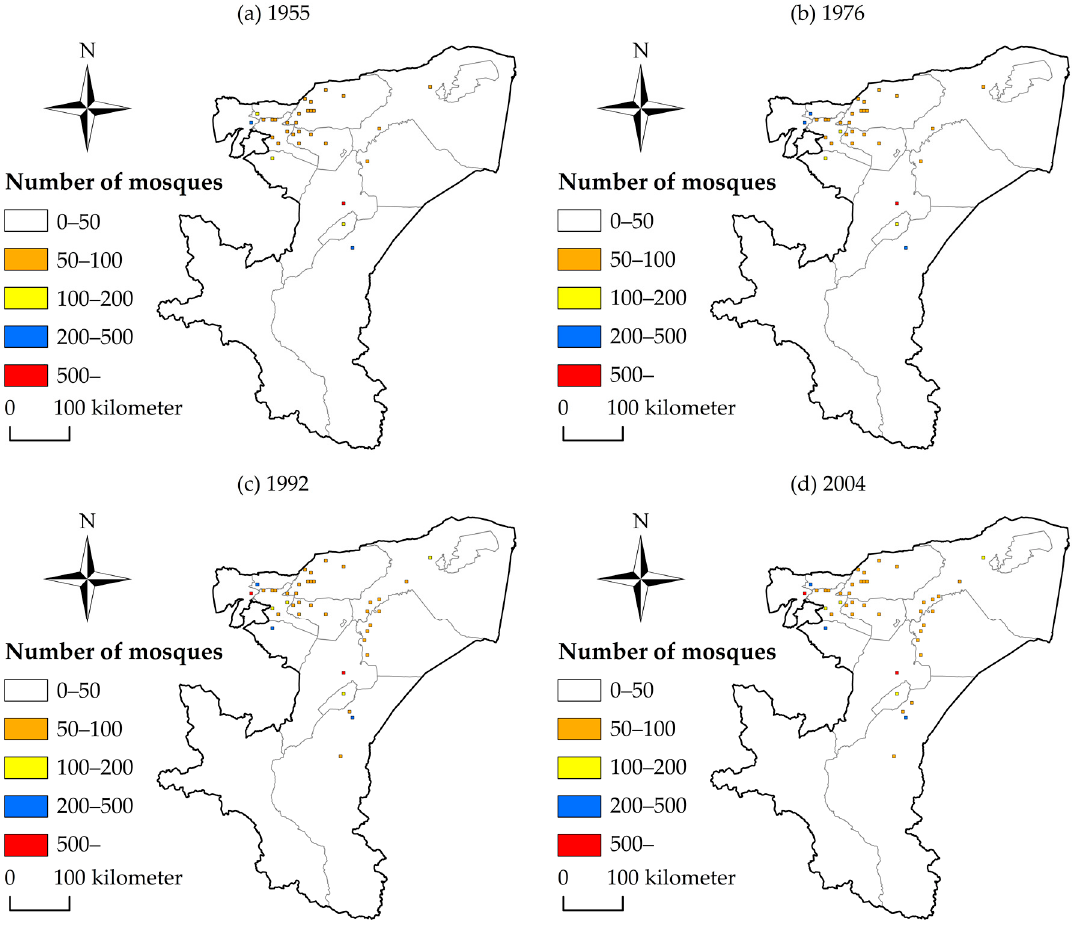
Figure 5. Spatially concentrated distribution of mosques in a fishnet of 5 km × 5 km in the Kashgar region from 1955 to 2004. Table 3. Rank distribution of aggregation units owned by each district and county of the Kashgar